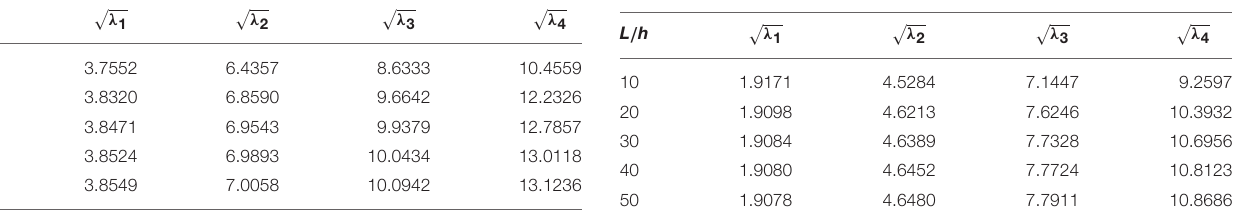
√ λ for CF case for different (cid:16) (cid:17)